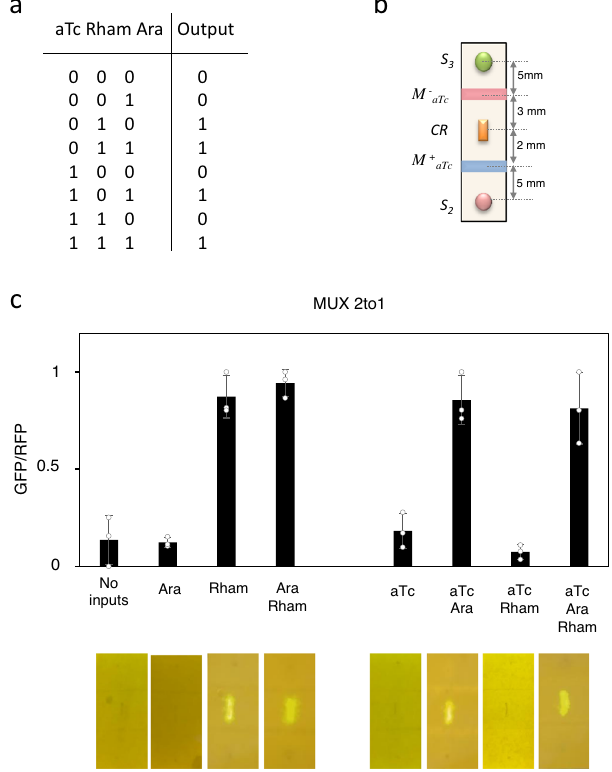
Fig. 4 Multiplexor 2 to 1. a Truth table of the 2 to 1 multiplexer. b Spatial pattern of cells encoding the multiplexer device with their corresponding distances. M + aTc and M − aTc are, respectively, positive and negative modulatory cells responding to aTc. S 2 cells produce AHL upon arabinose induction and S 3 cells produce AHL upon rhamnose induction. CR are the reporter cells. c Multiplexer response upon input of the indicated combinations. Input concentrations are Ara = 10 − 3 M, aTc = 10 − 6 M and Rham = 1.5%. Error bars are the standard deviation (SD) of three independent experiments. Data are presented as mean values ± SD. The average fold change has been obtained from the mean of ON and OFF states from each input combination. Multiplexor 2 to 1 fold change: 6.76x. Source data are provided as a Source Data fi